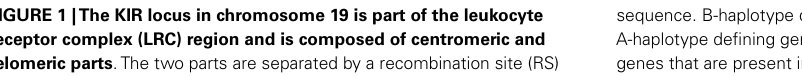
FIGURE 1 |The KIR locus in chromosome 19 is part of the leukocyte receptor complex (LRC) region and is composed of centromeric and telomeric parts .The two parts are separated by a recombination site (RS)